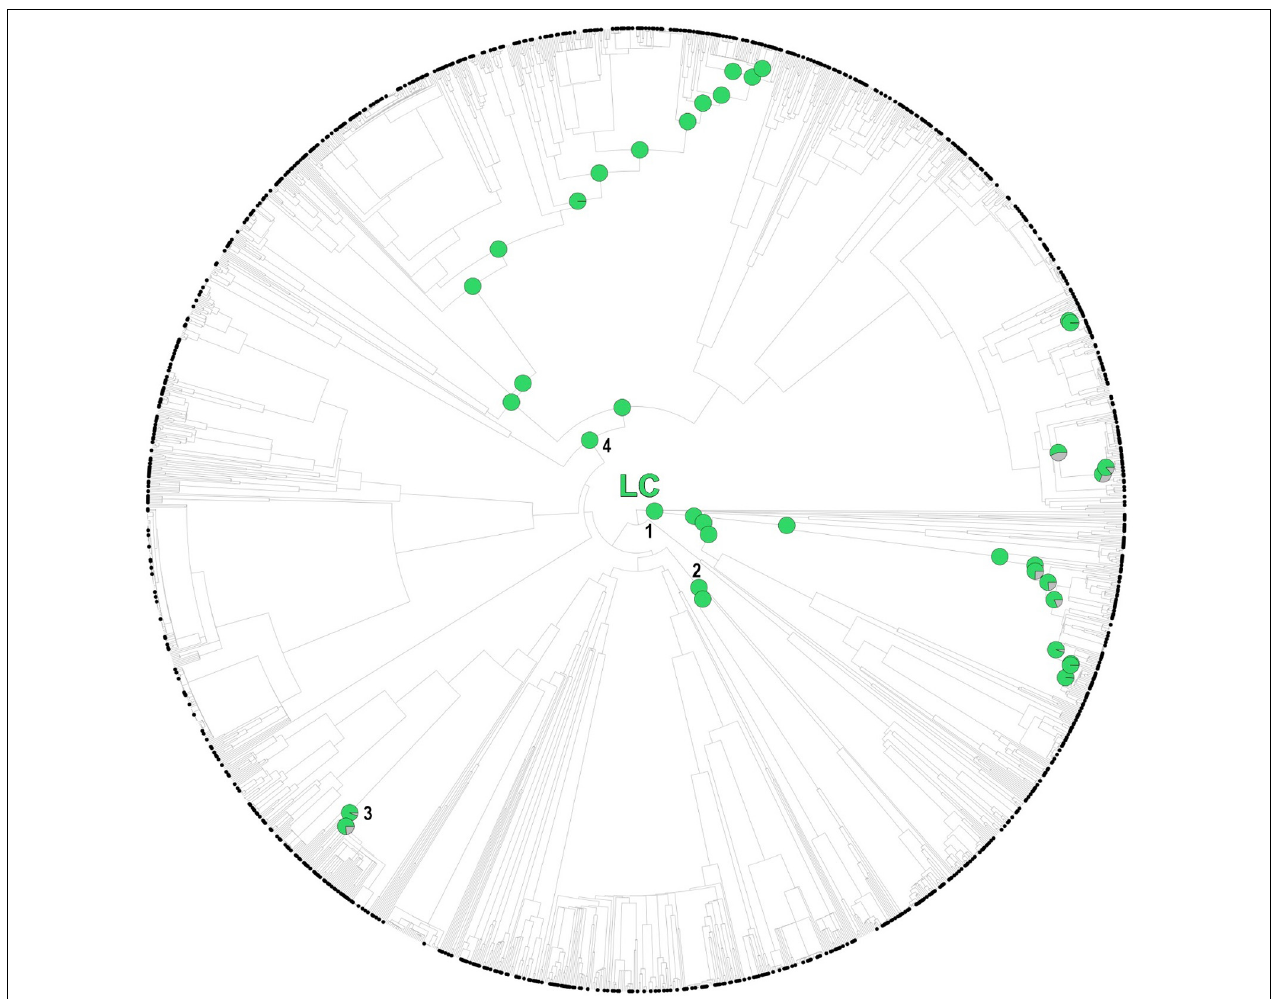
FIGURE 4 | One randomly selected tree topology for the endemic angiosperm flora of the Iberian Peninsula that included all the hot clades detected in the analysis (LC category). Hot nodes are marked with pie charts, representing level of support for the nodes, this is, the number of times they were observed with statistical significance (5% nominal alpha) across all the trees analyzed. The circle symbols on the phylogenetic tips represent LC species. 1: monocots, 2: Saxifragales, 3: Genisteae (Fabaceae), 4: